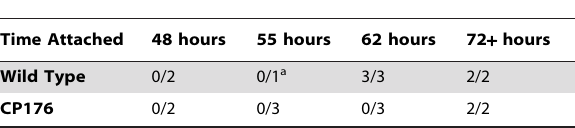
Table 3. Kinetics of Mouse Infectivity by Tick